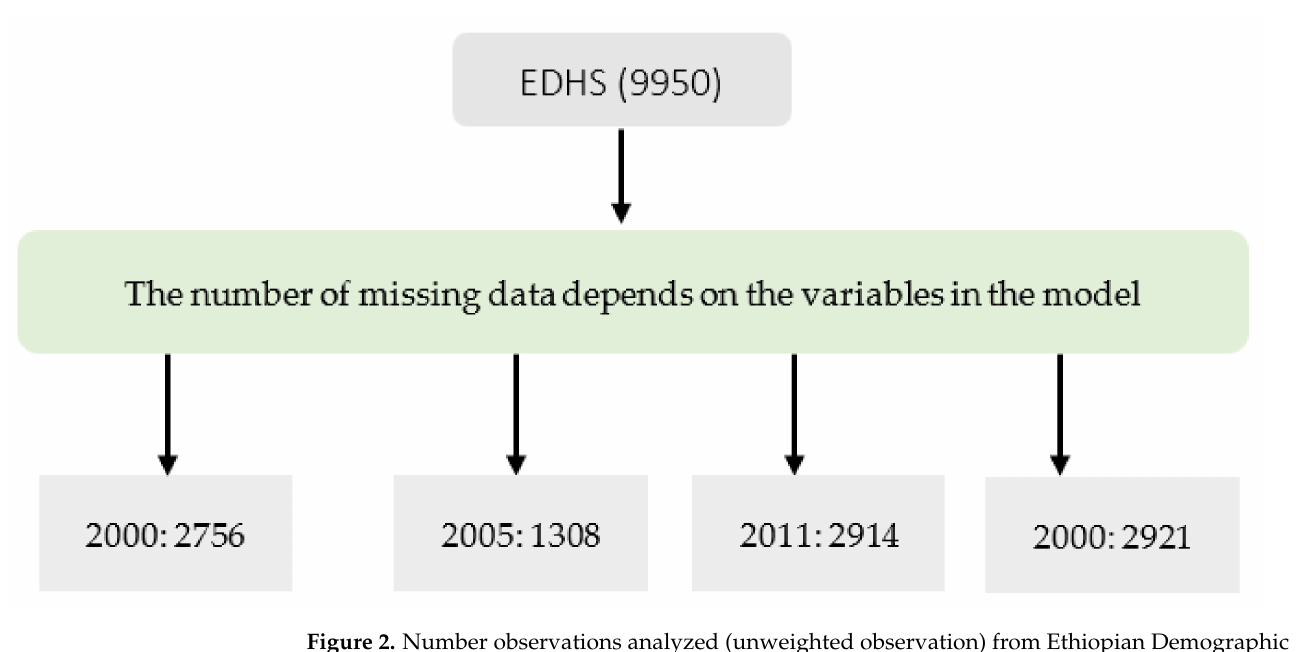
Figure 2. Number observations analyzed (unweighted observation) from Ethiopian Demographic and Health Survey (EDHS). The survey respondents had a comparable age across survey rounds, with a mean age of 28 years. Women with primary-school education and above ranged from 12% to 38%. The women-headed households increased from 10% in 2000 to 16% in 2016, with only a third of women in paid work. Respondents were predominantly maternal (86.2% to 90%). The proportion of households in the poor wealth tercile ranged from 17.7% to 38% (Table 2). Table 2. Participant characteristics of households with children 6–24 months, EDHS 2005 to 2016